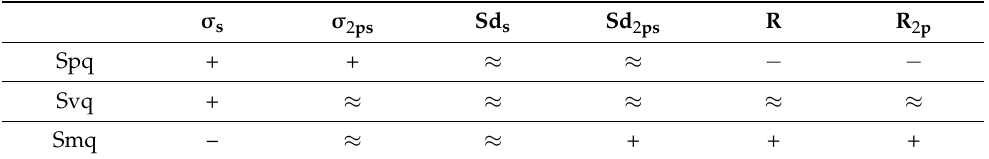
Table 1. The relations between the parameters Spq, Svq, and Smq and the parameters of summits, after [93].